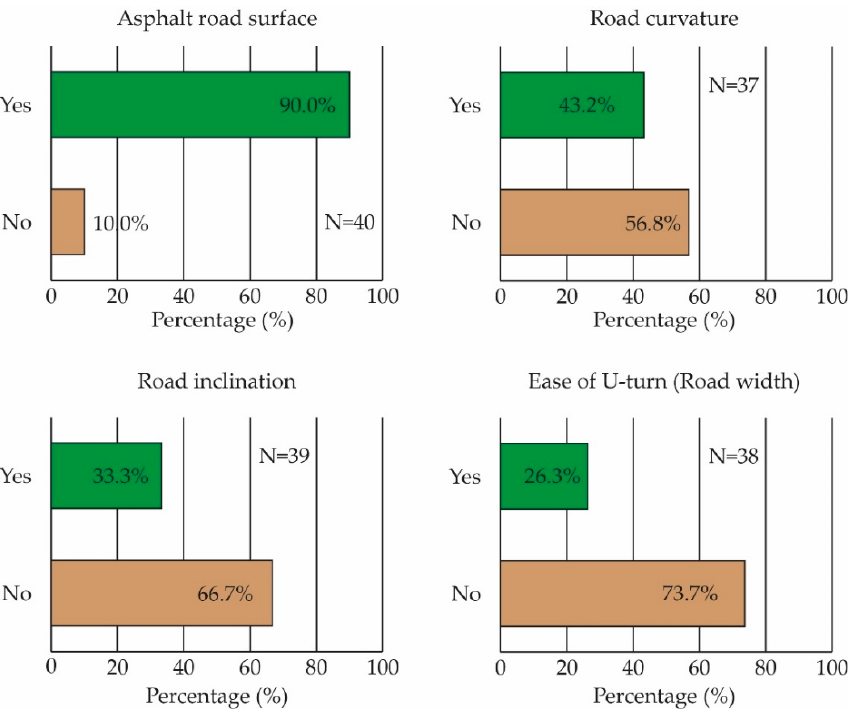
Figure 8. Distribution of cases with respect to road geometry characteristics.